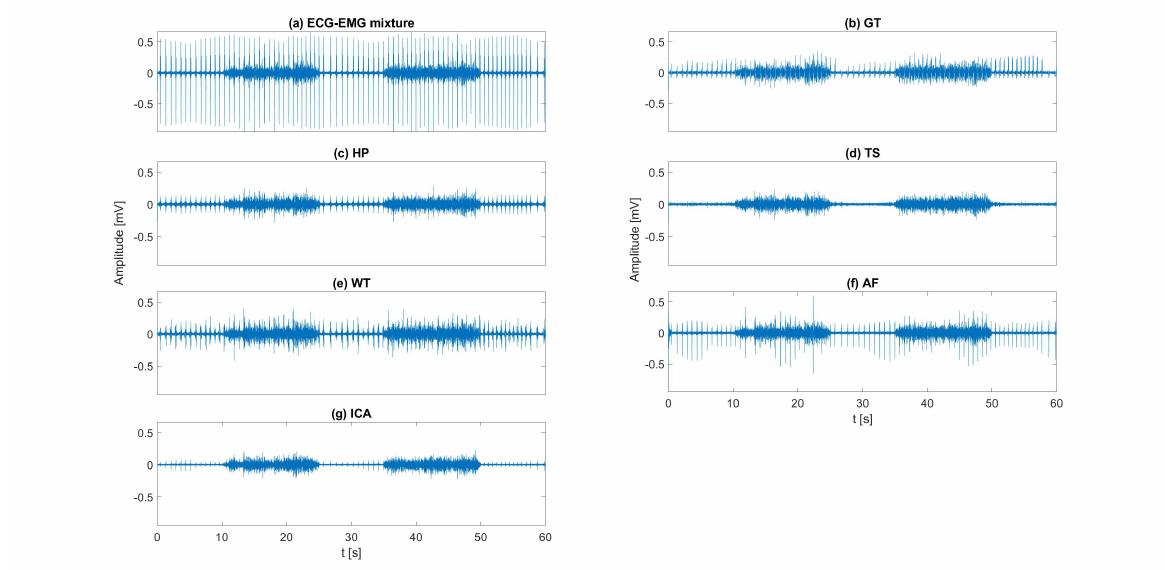
Figure 5. Example of ECG removal: ( a ) ECG-EMG mixture; ( b ) EMG reconstructed by GT; ( c ) EMG reconstructed by HP; ( d ) EMG reconstructed by TS; ( e ) EMG reconstructed by WT; ( f ) EMG reconstructed by AF; ( g ) EMG reconstructed by